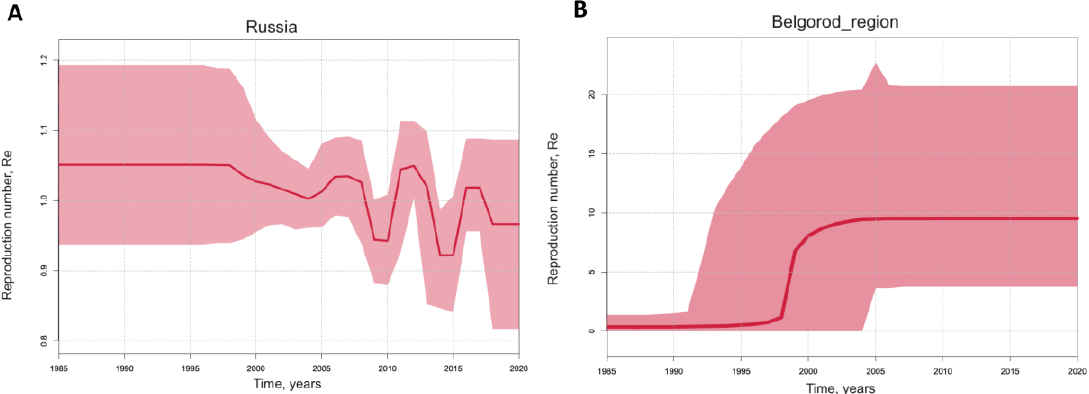
Figure 7. Birth-death skyline reconstruction for HEV-3 in Russia (A) and separately for Belgorod Region (B). The graphs show the relationship between the reproduction number of infection (y-axis) and chronological time expressed in years (x-axis). The curves indicate the mean, with the 95% HPD interval shown in pink shading. Estimates were obtained using 101 sequences of the HEV-3 ORF-2 fragment (300 nt), including 41 sequences from Belgorod Region.